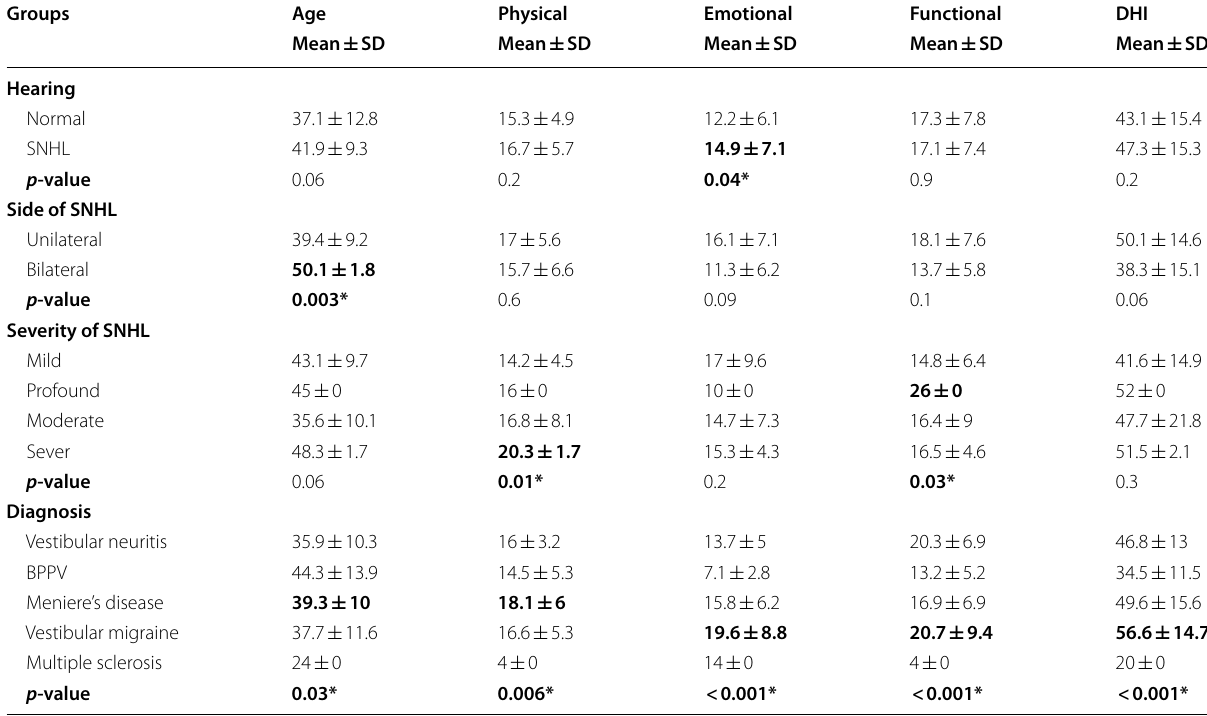
* P -value< 0.05 was considered as statistical significant